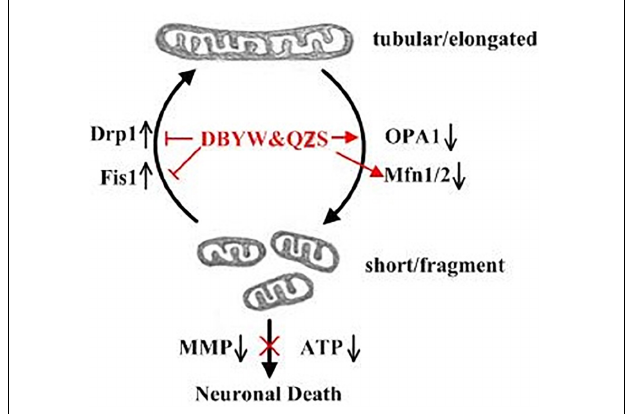
FIGURE 5 | Summary of the DBYW and QZS on mitochondrial dynamics in the PD cell model induced by MPP + . Both fission and fusion enable dynamic morphological changes of the mitochondrial network contributing to mitochondrial maintenance, function and quality control. While Mfn1/2 and OPA1 mediate the fusion of the mitochondrial outer and inner membrane, respectively, Drp1 is a key factor in mitochondrial fission. Fis1 localizes on the mitochondrial outer membrane and can recruit Drp1 to participate in the fission of mitochondria. We found that individual mitochondria disclosed a fragmented structure, lack of ATP, loss of mitochondrial membrane potential were more prominent in MPP + treated SH-SY5Y cells. In addition, the MPP + induced increase in Drp1 and Fis1, as well as decrease in Mfn1, Mfn2 and OPA1 were all partially prevented by DBYW and QZS, indicating that DBYW and QZS induced protection against MPP + induced toxicity is mediated by preservation of the balance between mitochondrial fission and fusion.